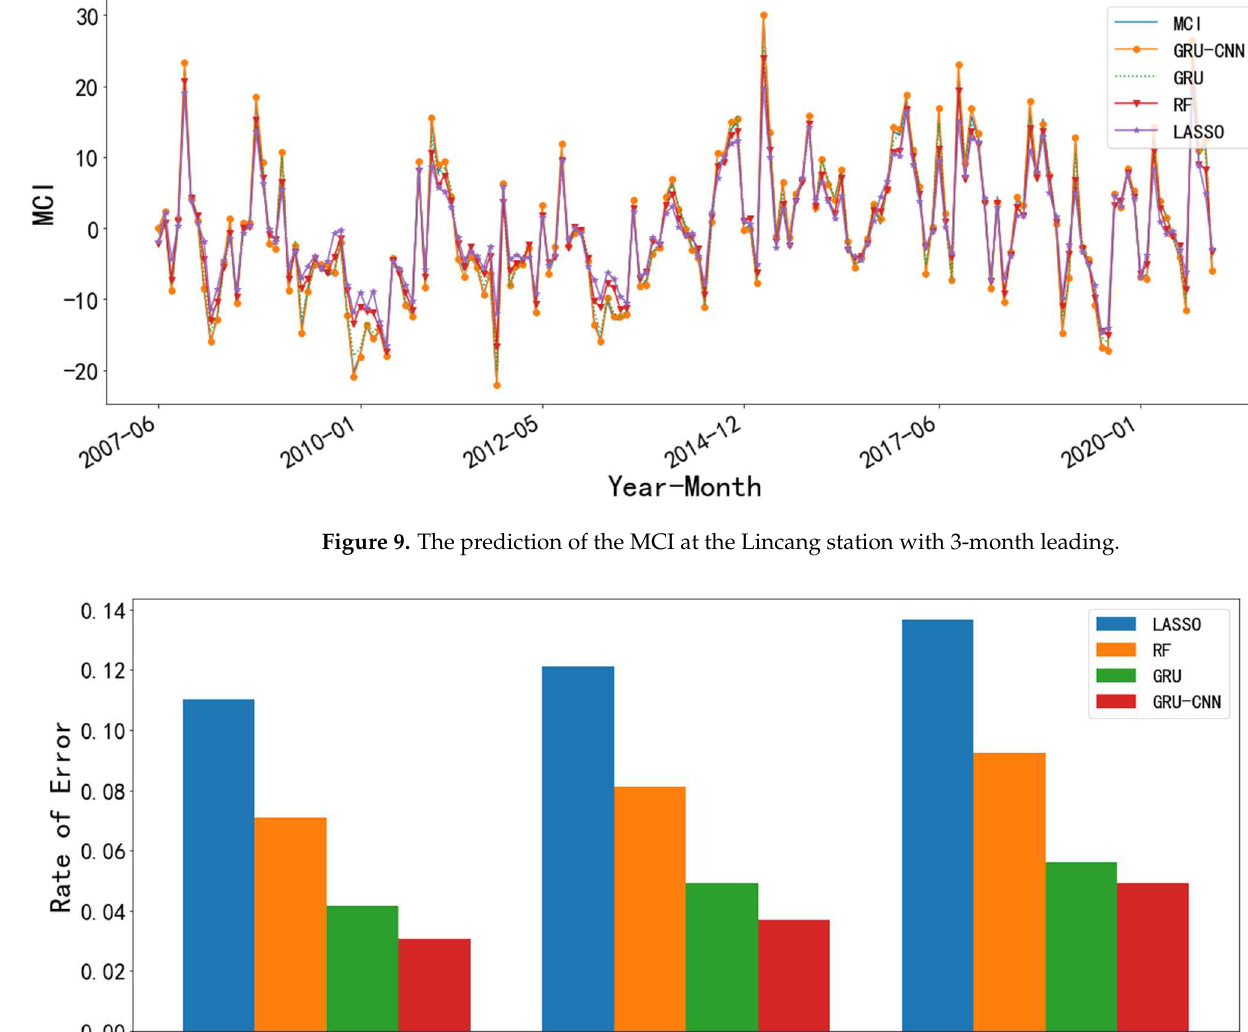
Figure 9. The prediction of the MCI at the Lincang station with 3-month leading.